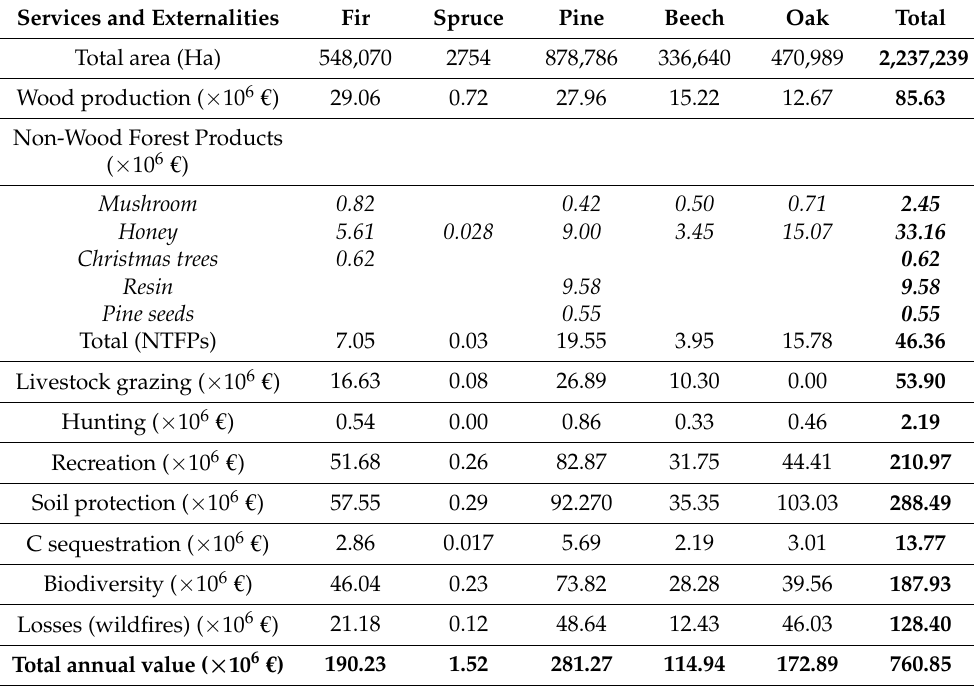
Table 2. Value (EUR) of forest per service and forest species.